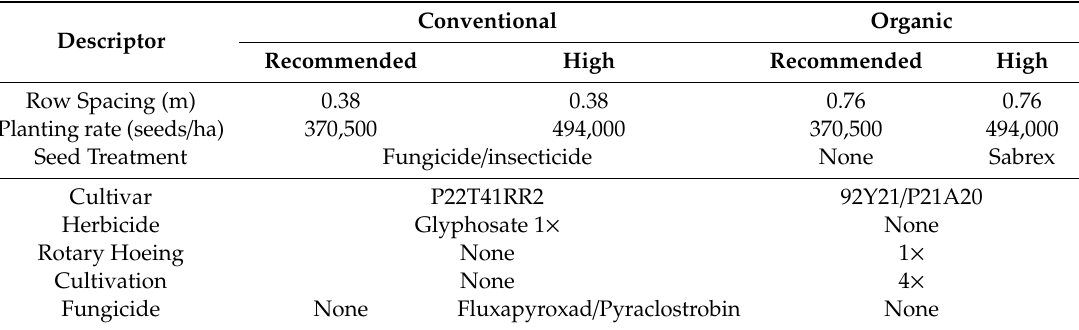
Table 2. Row spacing, planting rate, seed treatment, cultivar, herbicide, rotary hoeing, cultivation and fungicide application for soybean in conventional and organic farming systems with two management inputs (recommended and high input) from 2015 to 2018 at a University Research Farm in central New York, USA. Conventional Organic Descriptor Recommended High Recommended High Row Spacing (m) 0.38 0.38 0.76 0.76 Planting rate (seeds / ha) 370,500 494,000 370,500 494,000 Seed Treatment Fungicide / insecticide None Sabrex Cultivar P22T41RR2 92Y21 / P21A20 Herbicide Glyphosate 1 × None Rotary Hoeing None 1 × Cultivation None 4 × Fungicide None Fluxapyroxad / Pyraclostrobin